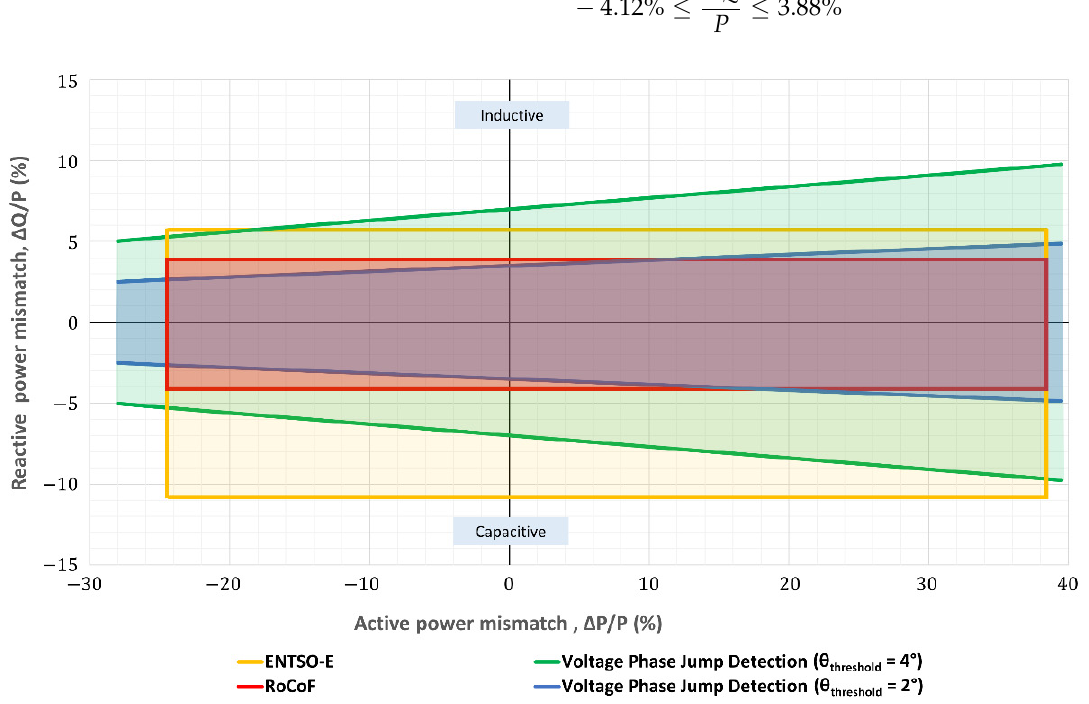
Figure 14. NDZ comparison between ENTSO-E, RoCoF and voltage phase jump detection for two different θ threshold .